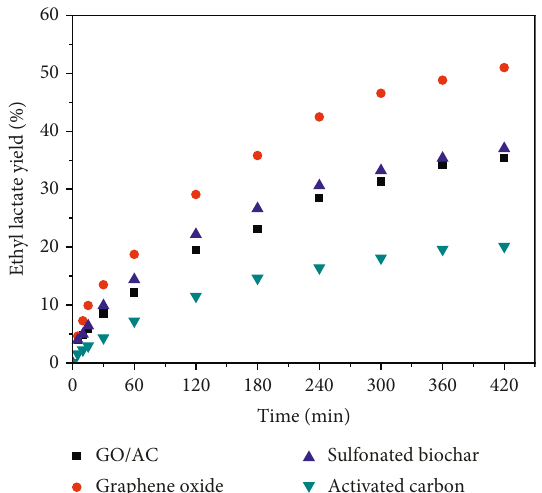
Figure 4: Ethyl lactate yield versus reaction